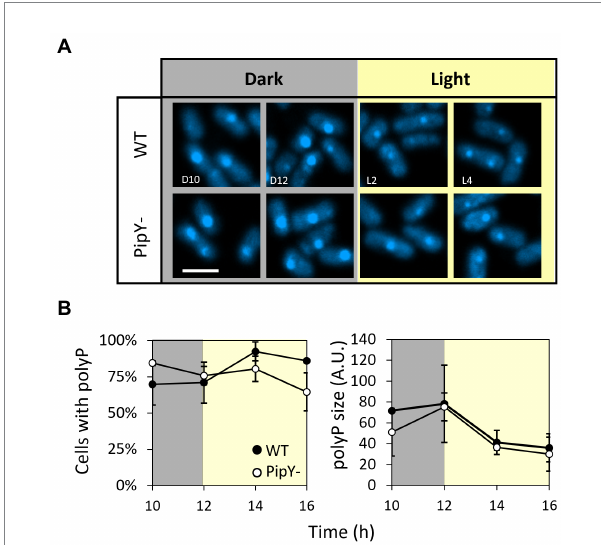
FIGURE 6 Inactivation of pipY does not impair the diurnal regulation of polyP accumulation. (A) Confocal micrographs showing DAPI-polyP staining of cells at dark (D10 and D12) and light (L2 and L4) timepoints during the L/D cycle. Cultures were trained in 12 h light/12 h dark cycles for 3 days. White scale bar, 2 μ m. (B) Percentage of cells with at least 1 polyP granule (left panel) and representation of granule size (right panel) as detected area in arbitrary units. Data are presented as mean and error bars (standard deviation) of two biological